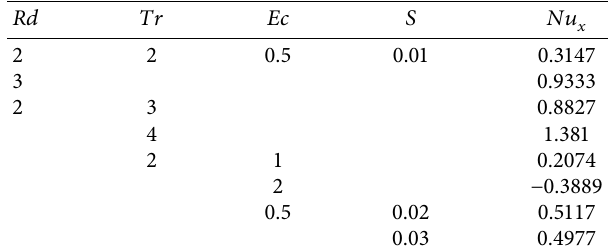
Table 2: Nusselt number.